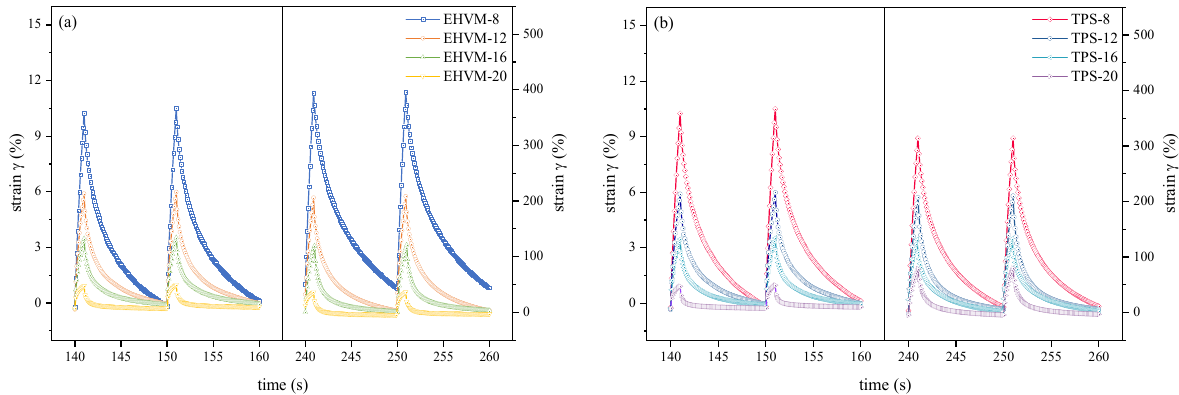
Figure 6. The accumulated strains of different HVA in 5th, 6th, 15th, and 16th cycle: ( a ) E-HVM modified asphalt and ( b ) TPS modified asphalt.